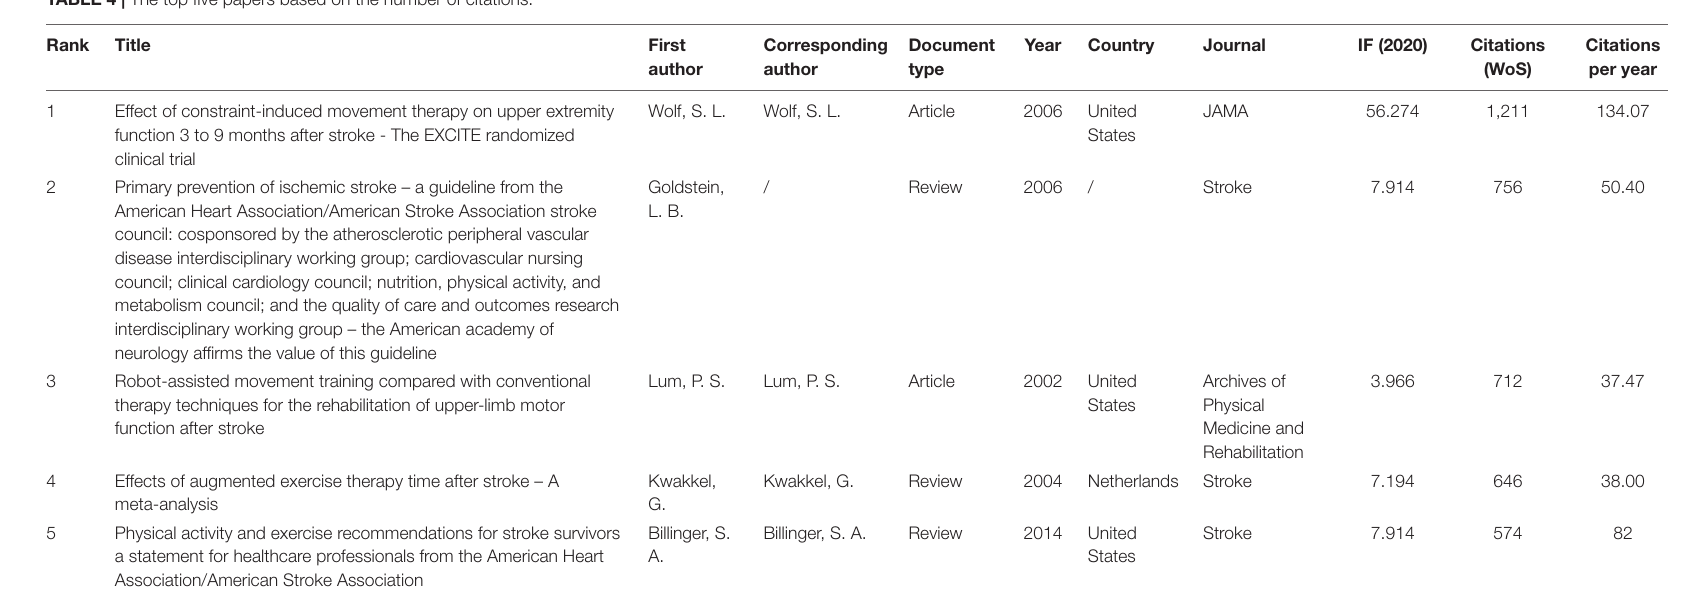
TABLE 4 | The top five papers based on the number of citations.